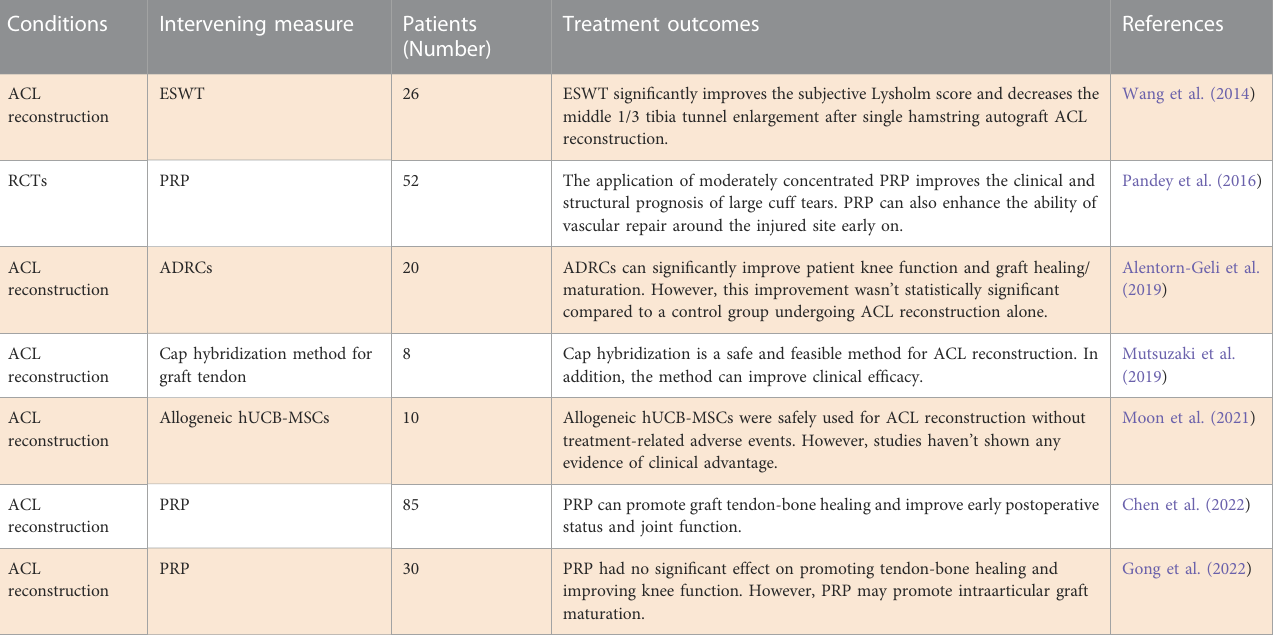
TABLE 8 Clinical studies on the promotion of tendon-bone healing.